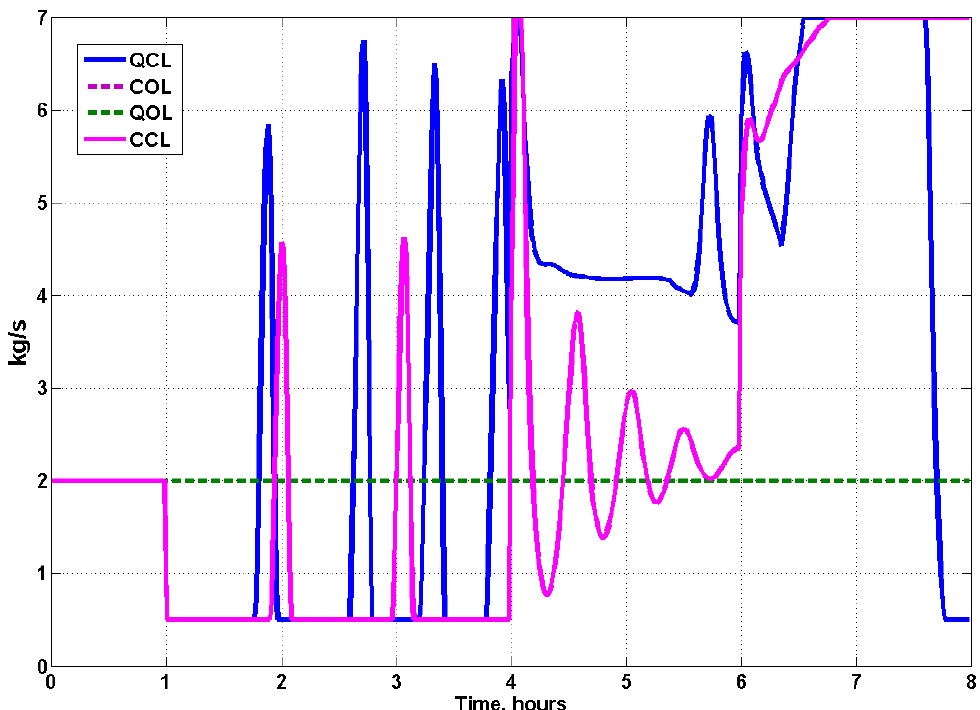
Figure 15. Enthalpy of manipulated variables (MV) of water.